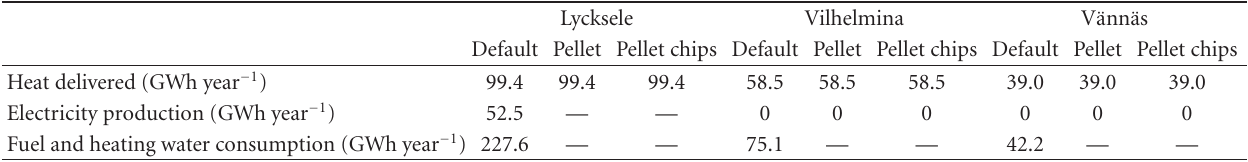
Table 3: Overview of current heat and electricity production for the three sites and the three production options: default (no dried fuel produced), pellet production (10% MC), and pellet chip production (15%